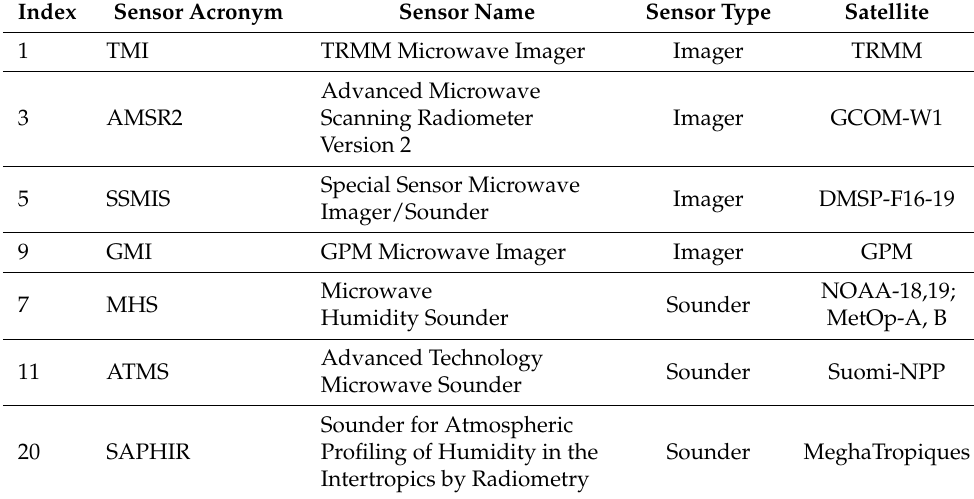
Table 2. Sensors included in IMERG V06B over Kwajalein for April 2014–June 2018. Index is the source. Number for each sensor in IMERG ancillary variable